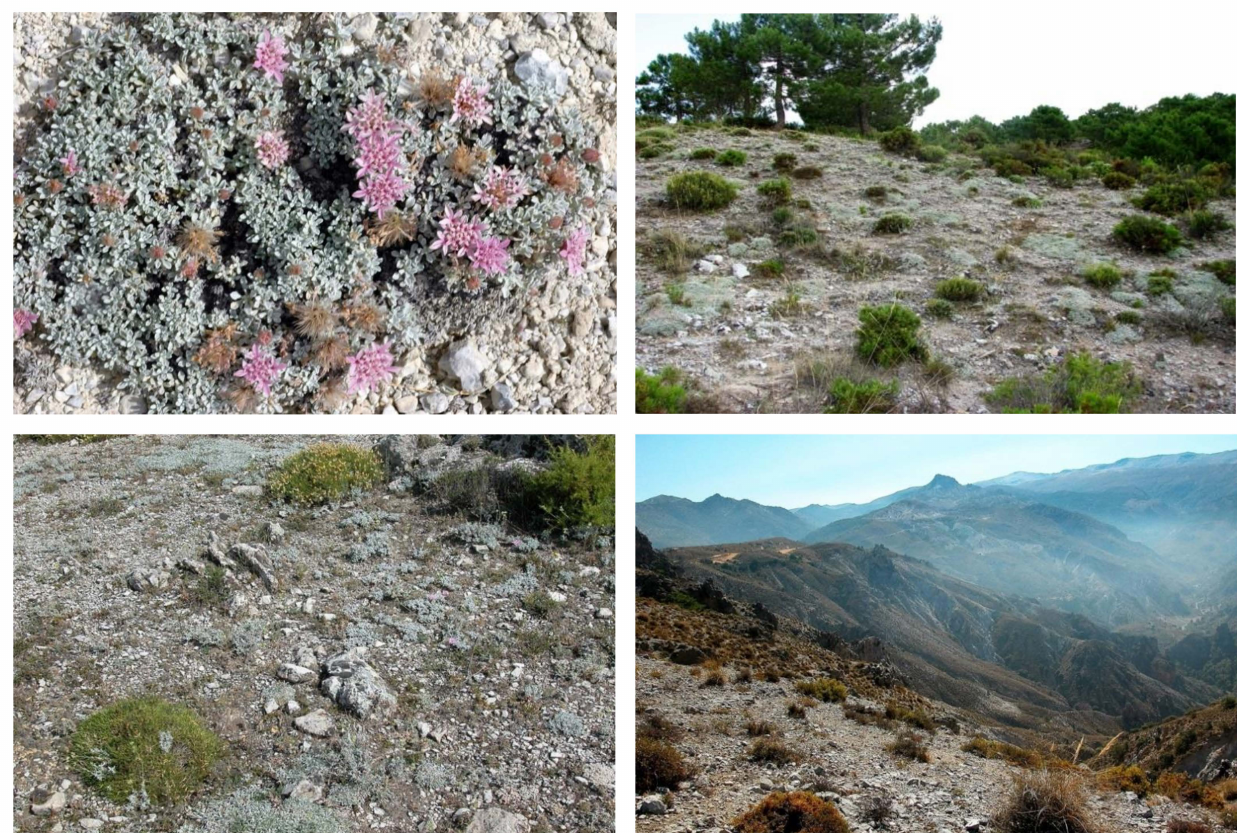
Figure 1. Images of plant species and dolomite vegetation community. ( Top left ): P. spathulatus ; ( top right ): La Peza (Sierra de Huetor); ( bottom left ): Association Andryalo agardhii-Convolvuletum boissieri Quezel 1953 nom. inv.; ( bottom right ): Boca de la Pesca (Sierra Nevada). (Photos by J.